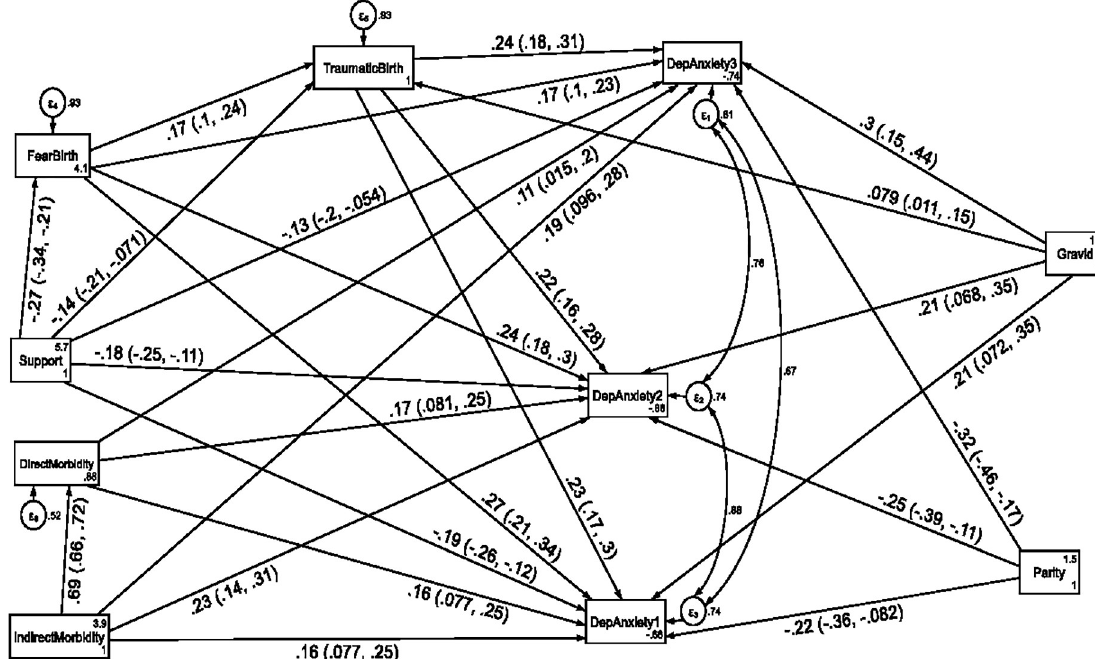
Fig 6. A structural equation model of the factors associated with comorbidity of depression and anxiety symptoms in postpartum women, Northwest Ethiopia. Note: β ’s are standardized estimates with 95% CI.